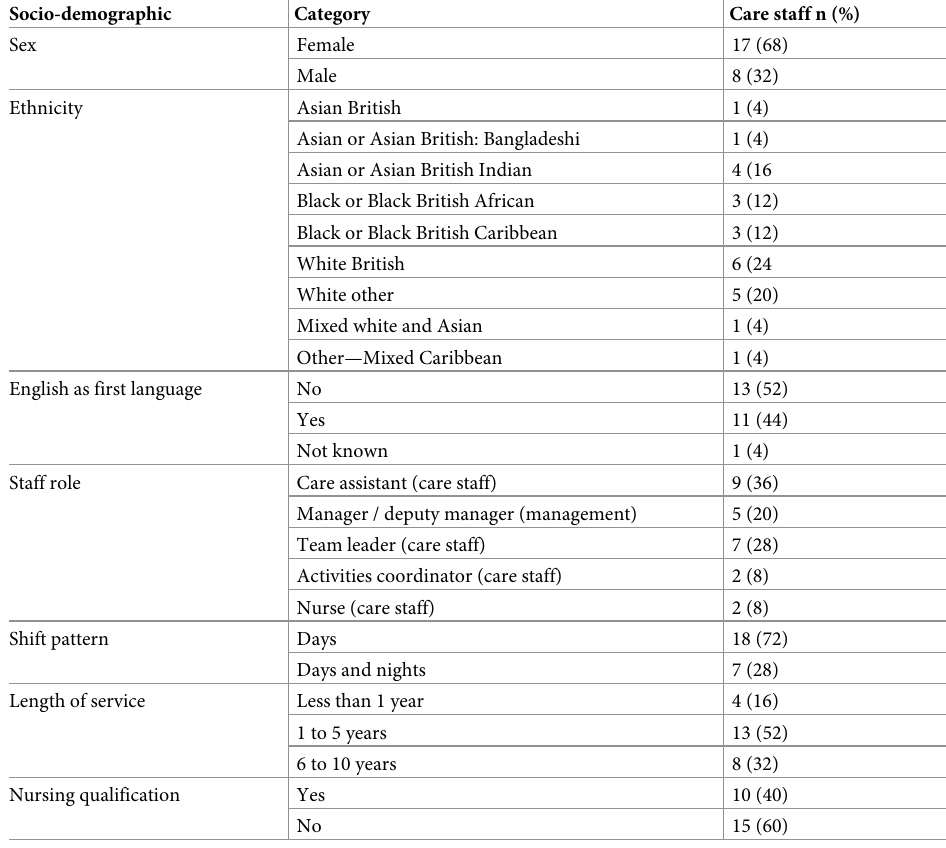
Table 1. Care staff socio-demographic and employment